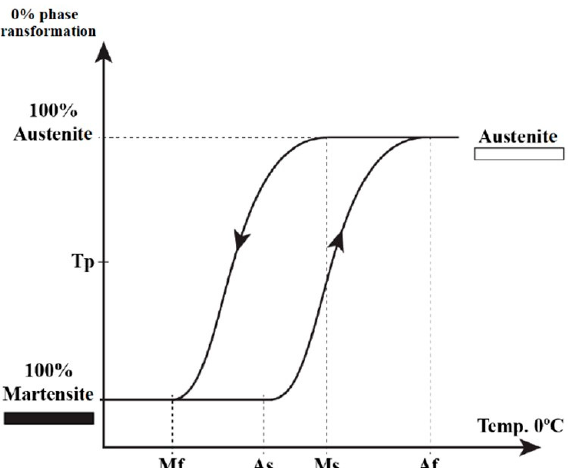
Figure 3. Thermogram of martensitic transformation temperatures. At a high temperature (100 ◦ C) the NiTi alloy is in the austenitic phase and if it is cooled, alloy change to the martensitic phase (Ms) up to a certain temperature at which all the crystals of the alloy have become martensitic (Mf). The same happens if the temperature increases, such that the temperature at which this phenomenon begins is called the austenite transformation start temperature (As) and the temperature at which this phenomenon is complete is called the austenite finish temperature